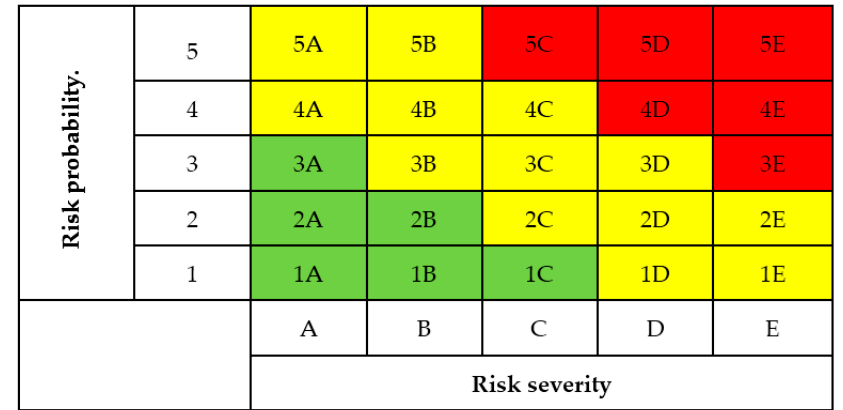
Figure 1. A custom version of the safety risk assessment matrix suggested in [27]. Red is a not acceptable risk level and require immediate mitigation action, yellow is a tolerable level and the safety risk should be mitigated as low as reasonably practicable, and green is an acceptable situation and no action is required. The matrix can be customized according to the organization’s safety policy. Reproduced from [27], Drone Industry Insights: 2015.